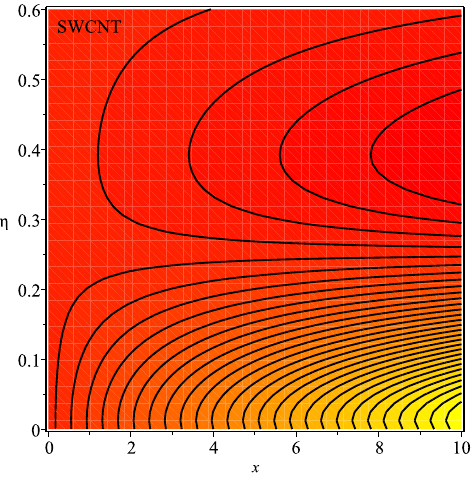
Figure 23. Repercussion of M egt = 1 with φ = 0.1, κ = 2, Ω = 1, ω = π /2, N = 10, Υ = 0.2, Pr = 100 on the